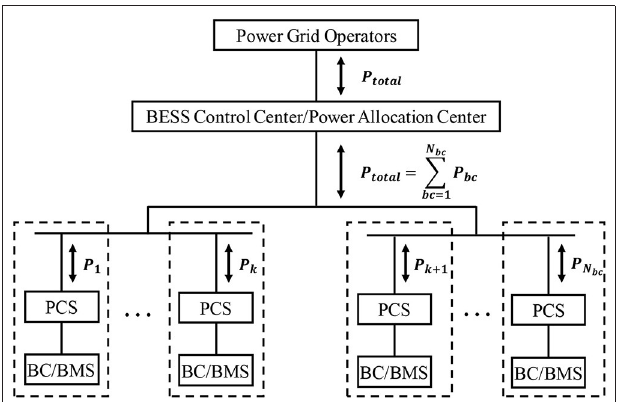
FIGURE 1 | A demonstration figure of power allocation in BESS